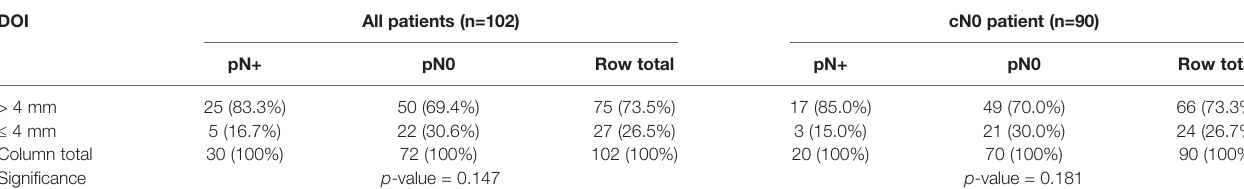
TABLE 3 | Cross-tabulations showing the relationship between DOI and pN status in all cancers (n=102) and in cN0 cancers (n=90).